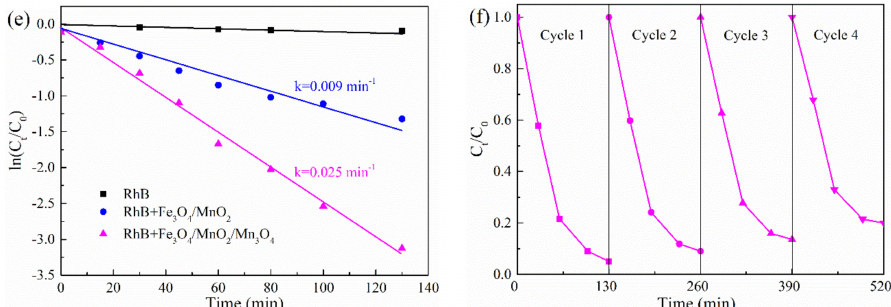
Figure 7. UV–vis spectra of RhB solutions in di ff erent performing times in the presence of pure RhB ( a ), Fe 3 O 4 / MnO 2 microspheres ( b ), and Fe 3 O 4 / MnO 2 / Mn 3 O 4 photocatalyst ( c ). Conversion of C t / C 0 for the degradation of RhB ( d ). Linear fit of experimental data by first-order kinetic model ( e ). Consecutive degradation of RhB with Fe 3 O 4 / MnO 2 / Mn 3 O 4 photocatalyst for four cycles ( f ). Reaction conditions: RhB = 65 mL of 10 mg / L; Catalyst = 10 mg; initial natural pH = 5.0 ± 0.1; Illuminant = 400 W metal halide lamp; T = 25 ◦ C; Time = 130